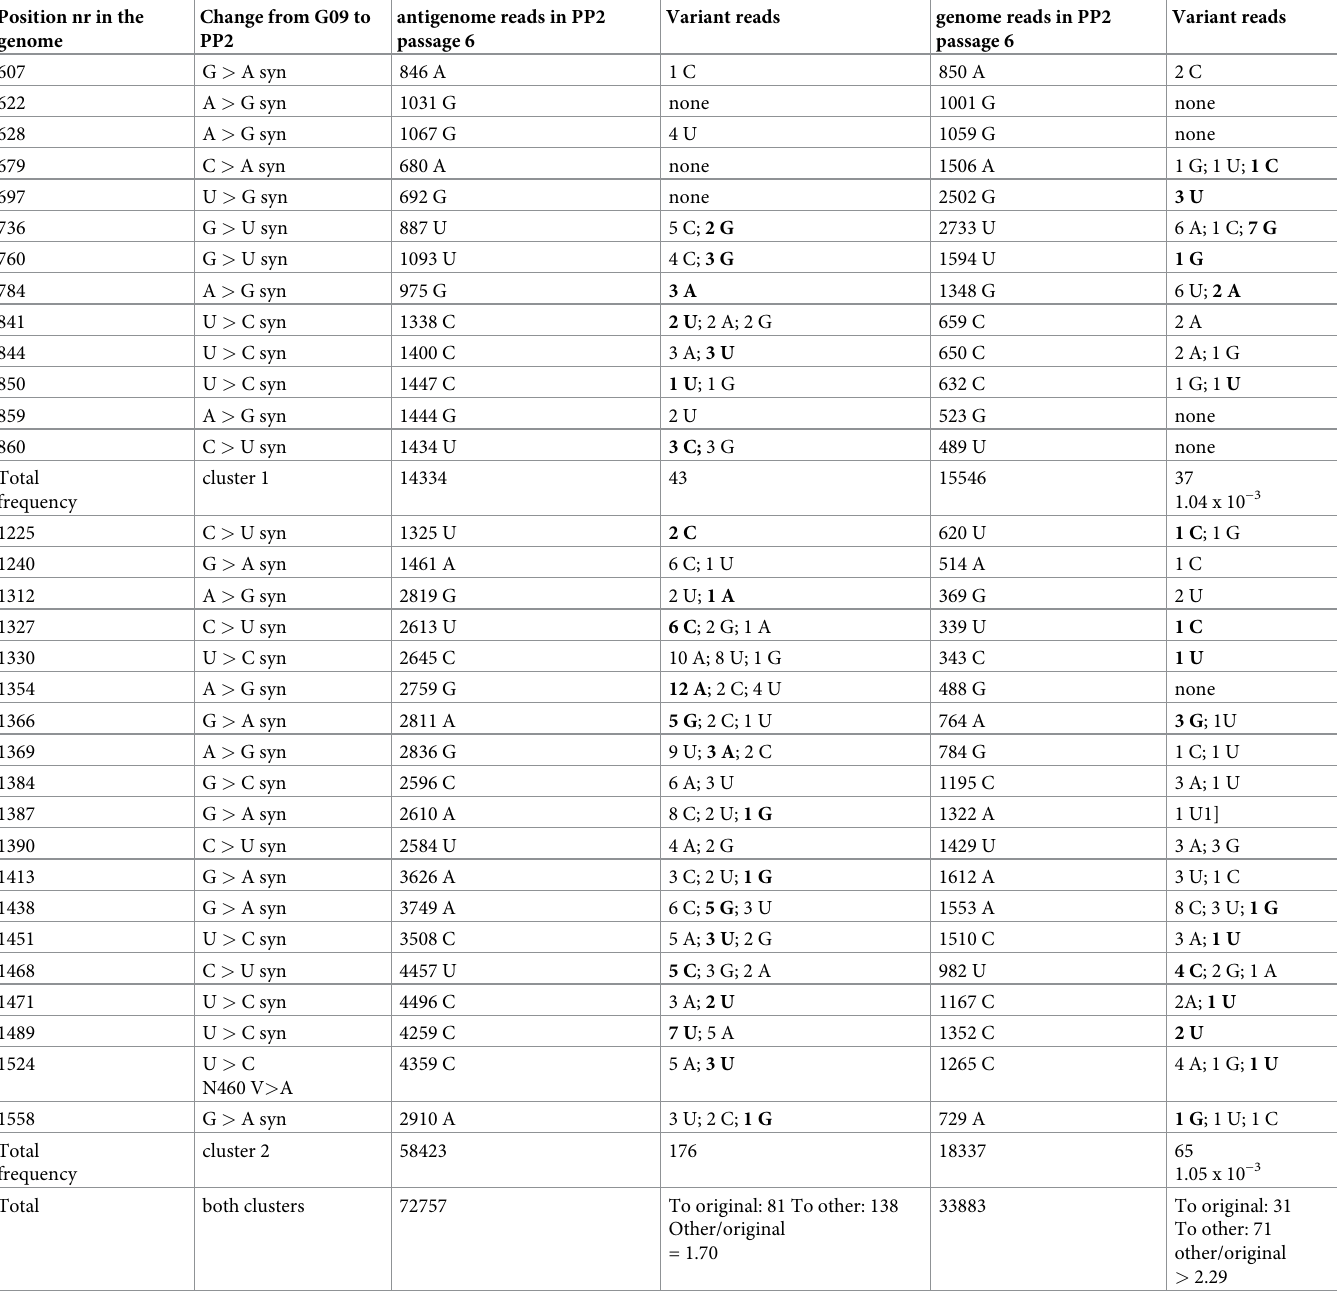
Table 2. Stability of the unique mutations in RNA extracted from semi-purified PP2 virus after 6 passages on B-LCL cells. Position nr in the Change from G09 to antigenome reads in PP2 genome PP2 passage